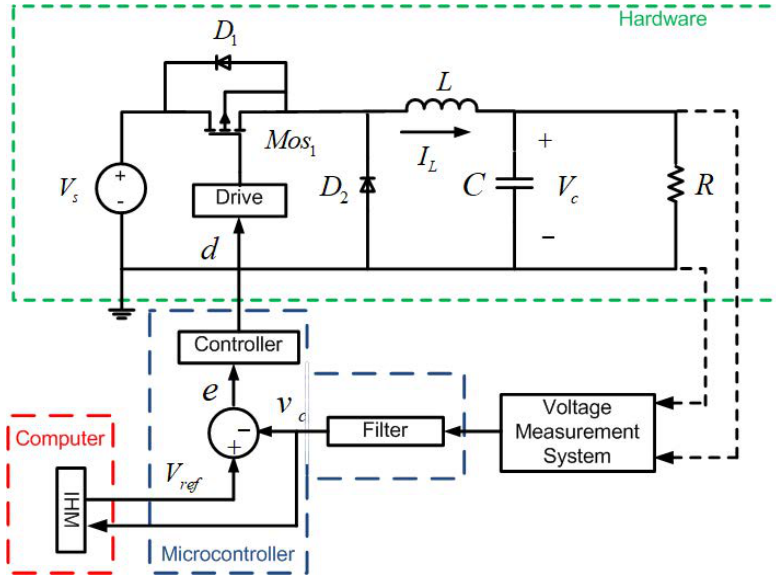
Figure 1. The typical topology of the DC-DC Buck power converter.